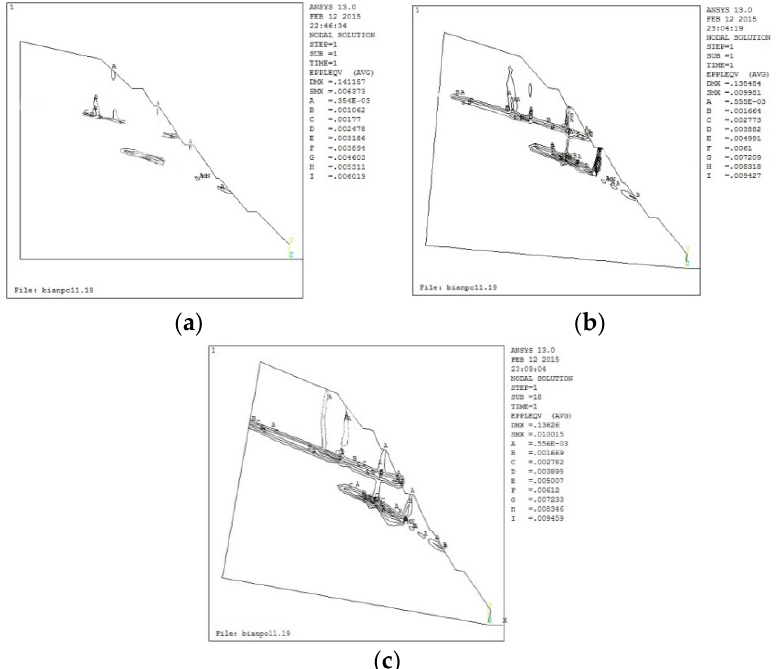
Figure17. Plasticfailureprocessisolineofnumericalcalculation. ( a )Undertheself-weight; ( b ) K P = 1.243 Figure 17. Plastic failure process isoline of numerical calculation. ( a ) Under the self-weight; ( b ) K P = (with uplift 5 ◦ ); ( c ) K P = 1.512 (with uplift 10 ◦ 1.243 (with uplift 5°); ( c ) K P = 1.512 (with uplift 10°).